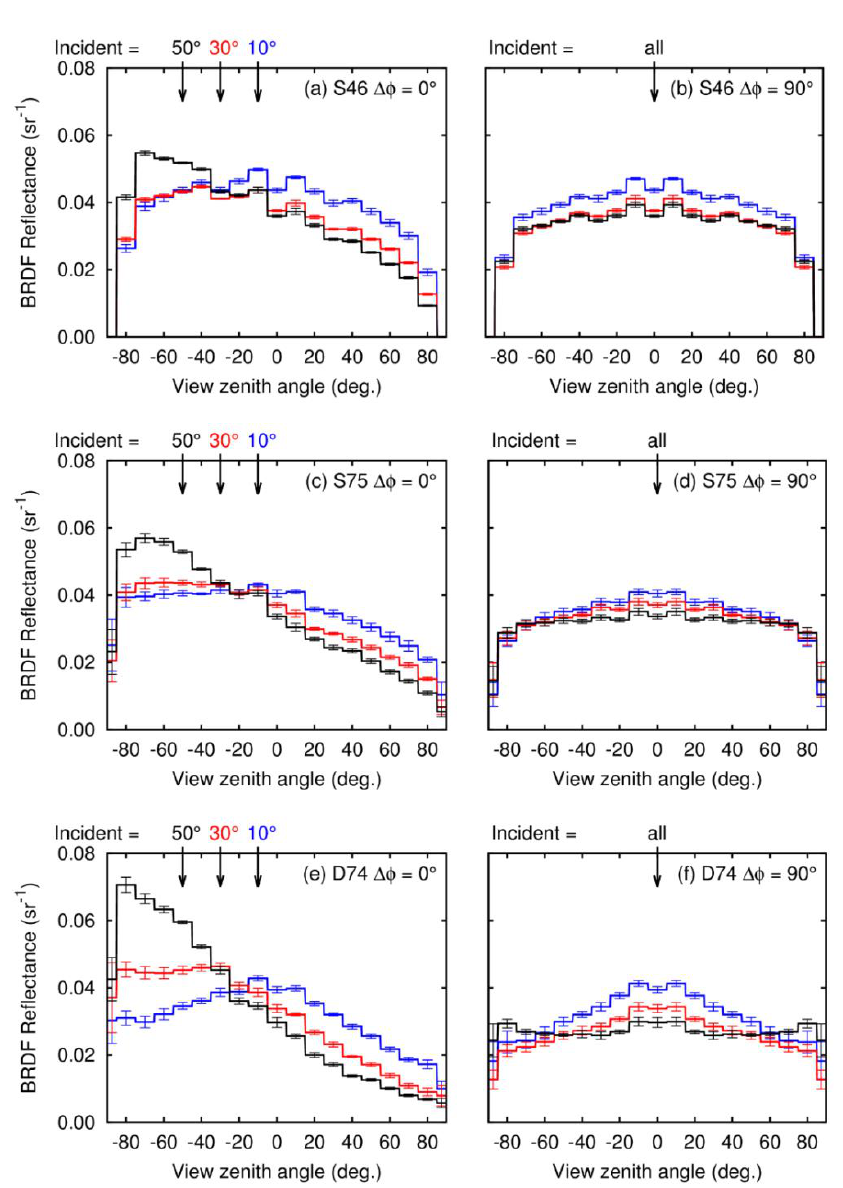
Figure 9. Bidirectional reflectance functions (BRDFs) at 550 nm, of three of the composite coral canopies for shallow (S, 0–10 m) and deep (D, 10–20 m) corals with areal cover: ( a , b ) 46%; ( c , d ) 75%; and ( e , f ) 74%, in the incident plane (a, c, e, ∆ ϕ = 0 ◦ ) and at 90 ◦ to the incident plane ( b , d , f , ∆ ϕ = 90 ◦ ). Arrows show direction of incident light, each plot shows θ i of 10 ◦ , 30 ◦ and 50 ◦ . Negative view zenith angle for ∆ ϕ = 0 ◦ ( a , c , e ) means backward reflection (source and view point in the same hemisphere). Error bars are ± 1 standard error on 12 values from assumed reciprocity, rotational and mirror symmetries.